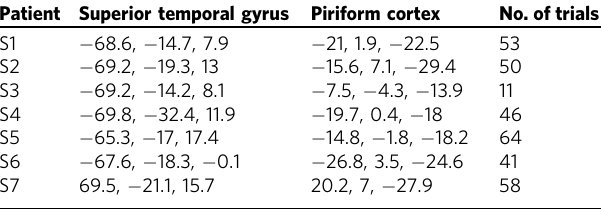
Table 2 MNI coordinates of regions of interest Patient Superior temporal gyrus Piriform